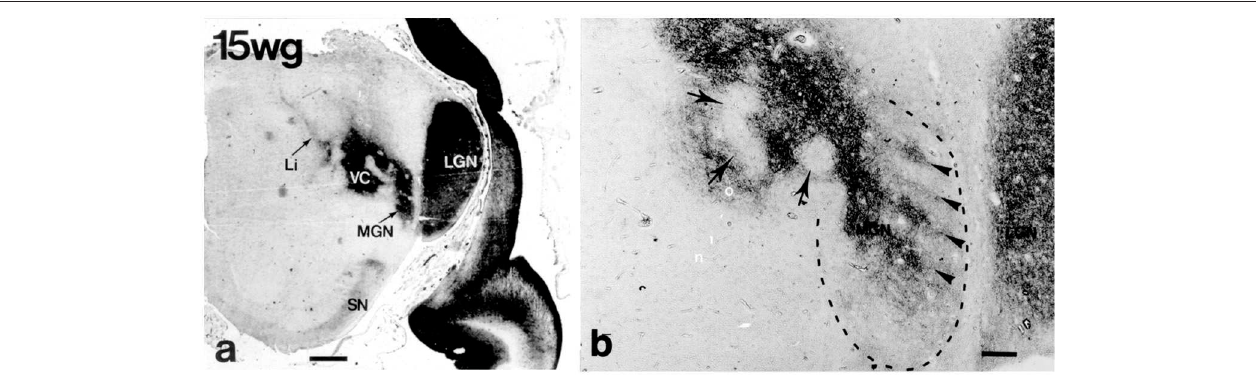
FIGURE 8 | Lateral (LGN) and medial (MGN) geniculate nuclei at 15 weeks of gestation (CD15 immunoreactivity) (from Mai et al., 1999; with permission). (a) The continuity of the future MGN with the ventroposterior complex (VC) is apparent. (b) Higher magnification shows that the curled, wavy or band like disposition of CD15 immunoreactivity in the ventral parvosellular subnucleus (arrowheads in area surrounded by dashed line) which might correspond to the tonotopically organized fibrodendritic laminae. Arrows indicate regions extending into VC. Scale bars 5mm in a and 100 µ m in (b) .